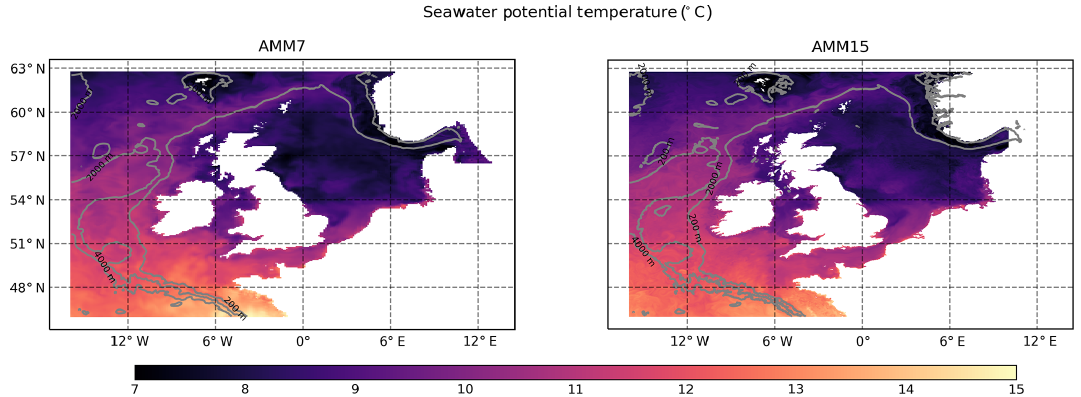
Figure 1. AMM7 and AMM15 co-located areas. Note the difference in the land–sea boundaries due to the different resolutions, notably around the Scandinavian coast. Contours show the model bathymetry at 200, 2000 and 4000m.